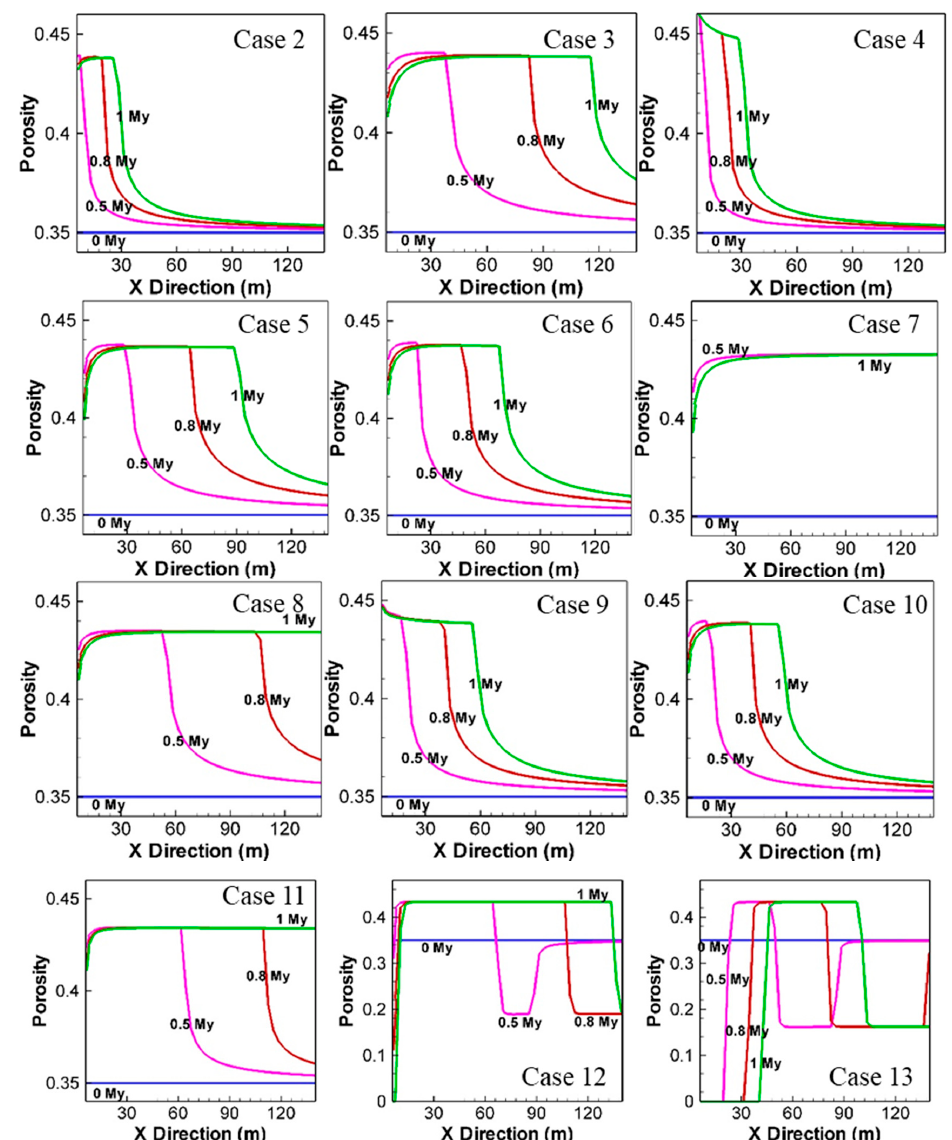
Figure 6. Porosity evolution in each model (Case 2–Case 13).